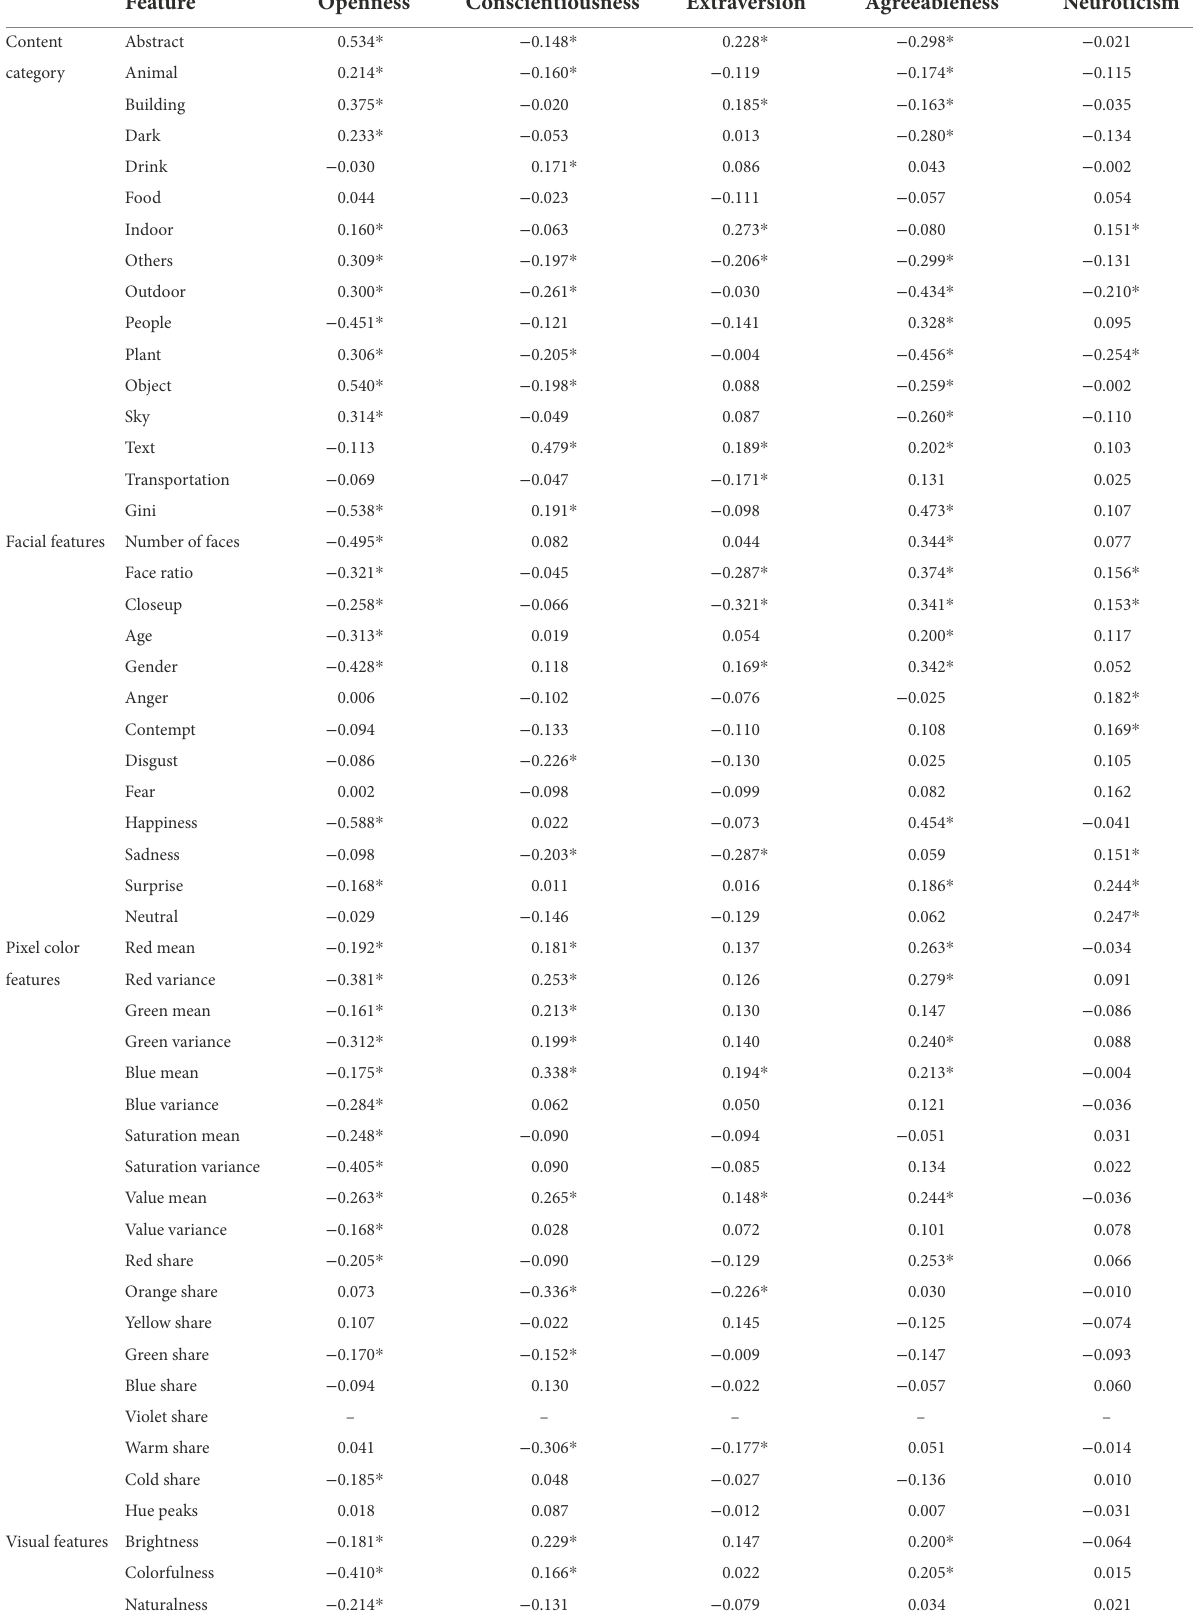
TABLE 3 Correlations between the personality traits of nonprofit organizations’ Instagram accounts and the features of their photos. Feature Openness Conscientiousness Extraversion Agreeableness